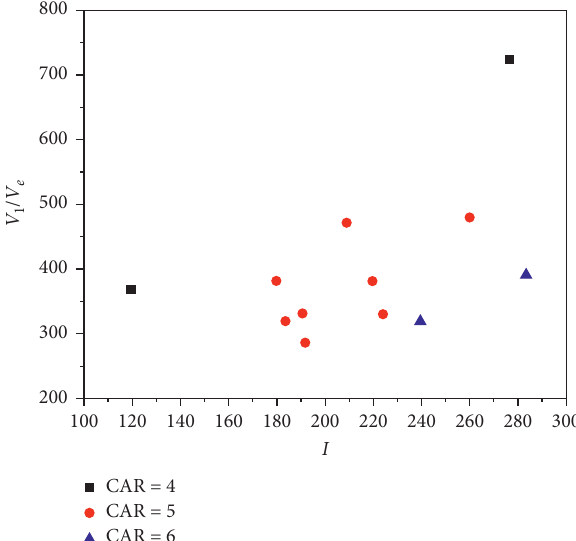
Figure 15: Experimental data in the dimensional damage volume. Crushing zone